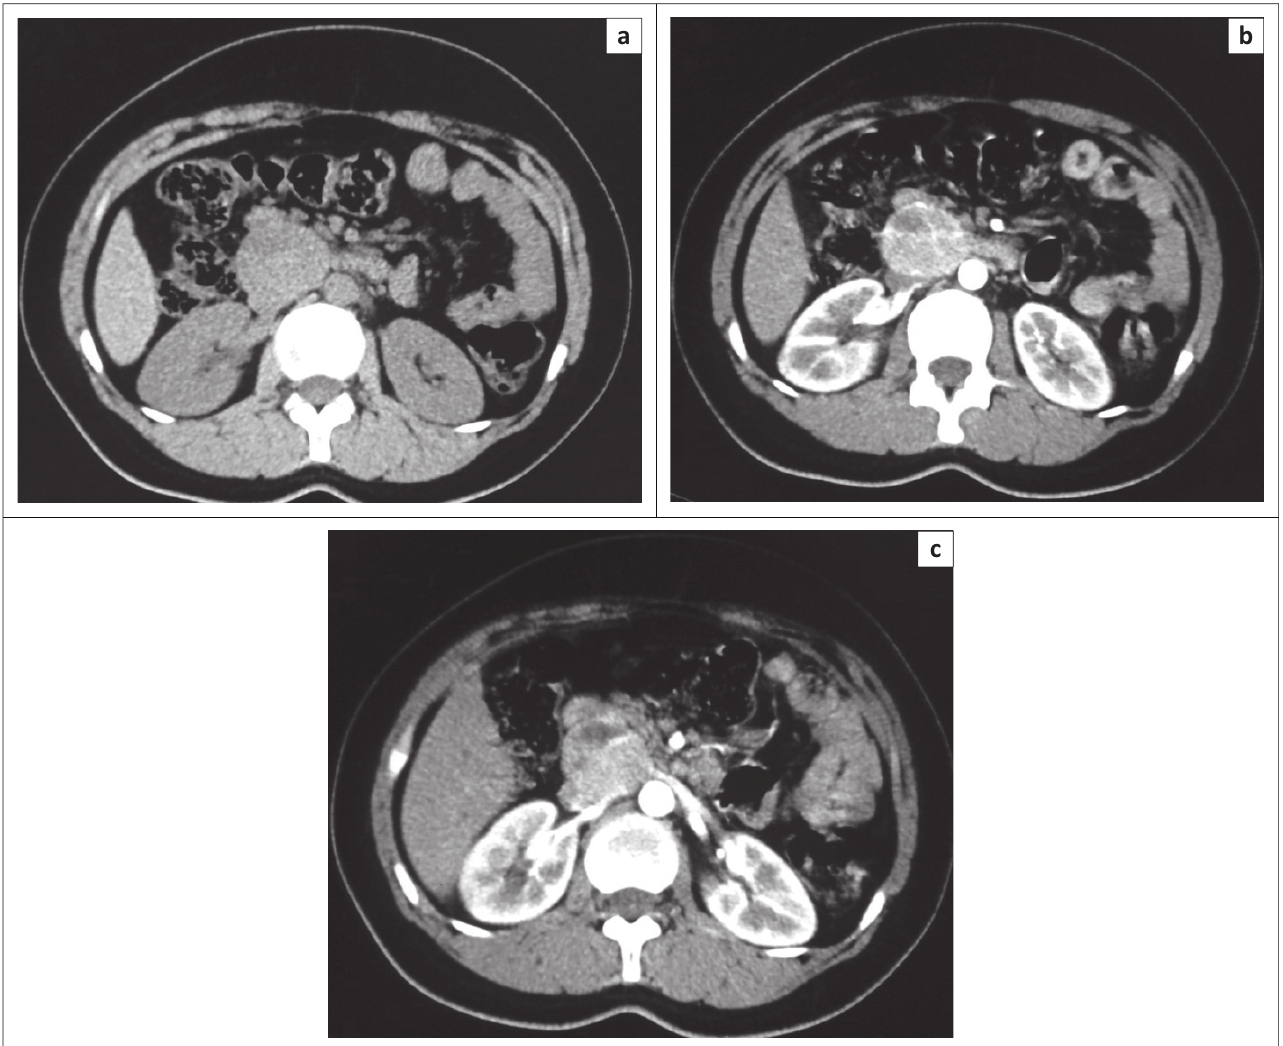
FIGURE 3: Axial non-contrast-enhanced computed tomography image (a) in a 26-year-old female patient showing a well-defined lesion in the pancreatic head or uncinate process with axial contrast-enhanced (b) and magnified post-contrast computed tomography image (c) showing an enhancing solid lesion with a non-enhancing component suggestive of solid pseudo-papillary tumour. Histopathology examination confirmed the